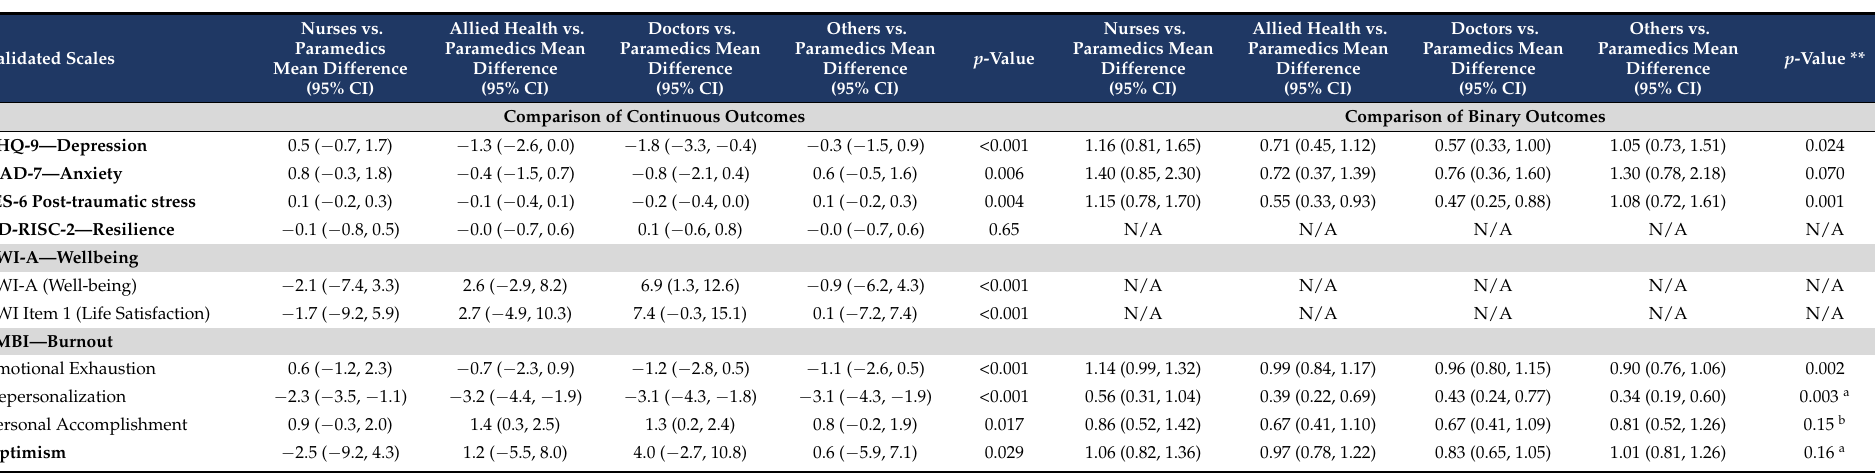
Table 3. Comparison * of continuous and binary outcomes for measures of depression, anxiety, post-traumatic stress, resilience, wellbeing, life satisfaction, burnout, and optimism across